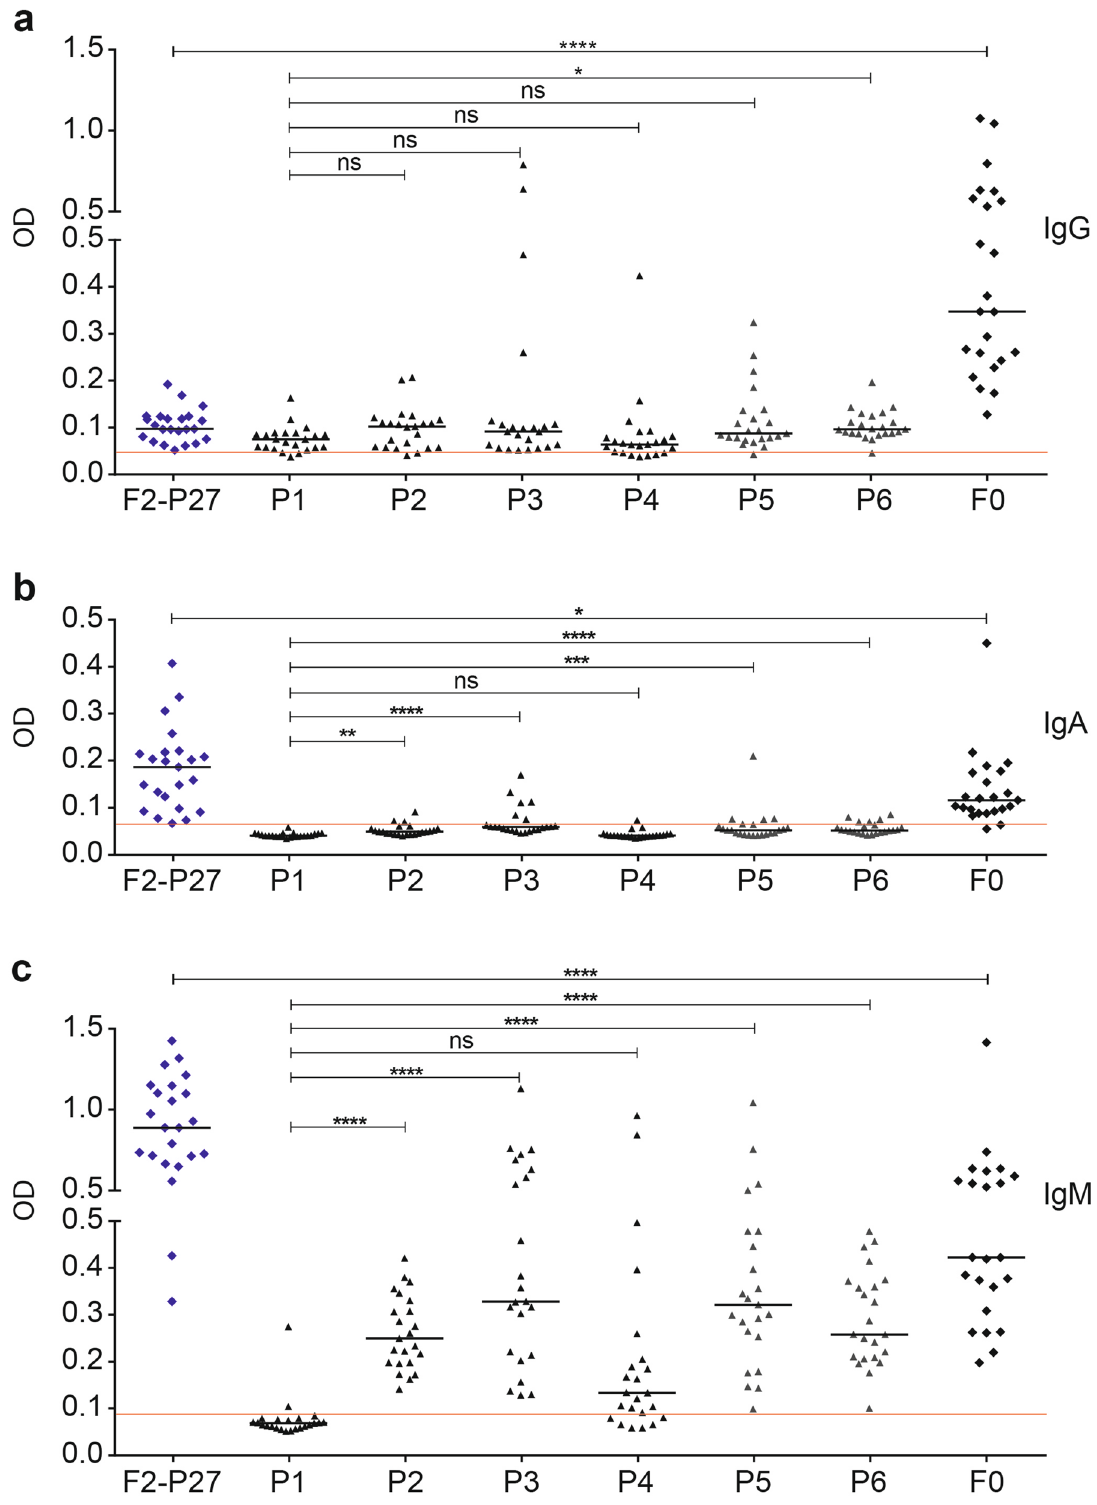
Figure 6. Human antibody responses to recombinant F2-P27, F0 and F2-derived synthetic peptides. Shown are IgG ( a ), IgA ( b ) and IgM ( c ) levels (y-axis: optical density values) in sera from 23 adult individuals to recombinant F2-P27, F0 and F2-derived synthetic peptides (P1–P6), (x-axis). Horizontal lines within scatter plots indicate median values. The cut-off (mean of buffer control plus three times standard deviation) is indicated by a red line. Significant differences of antibody responses are indicated: ns (not significant); *p < 0.05; **p < 0.001; ***p <